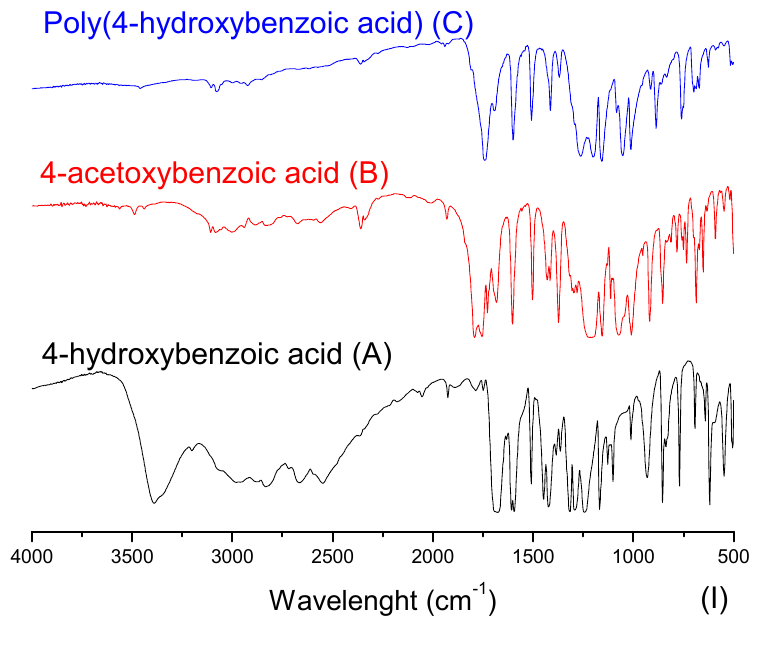
Figure 6. FTIR spectra of the polyesters obtained from experimental procedures 1 and 2.